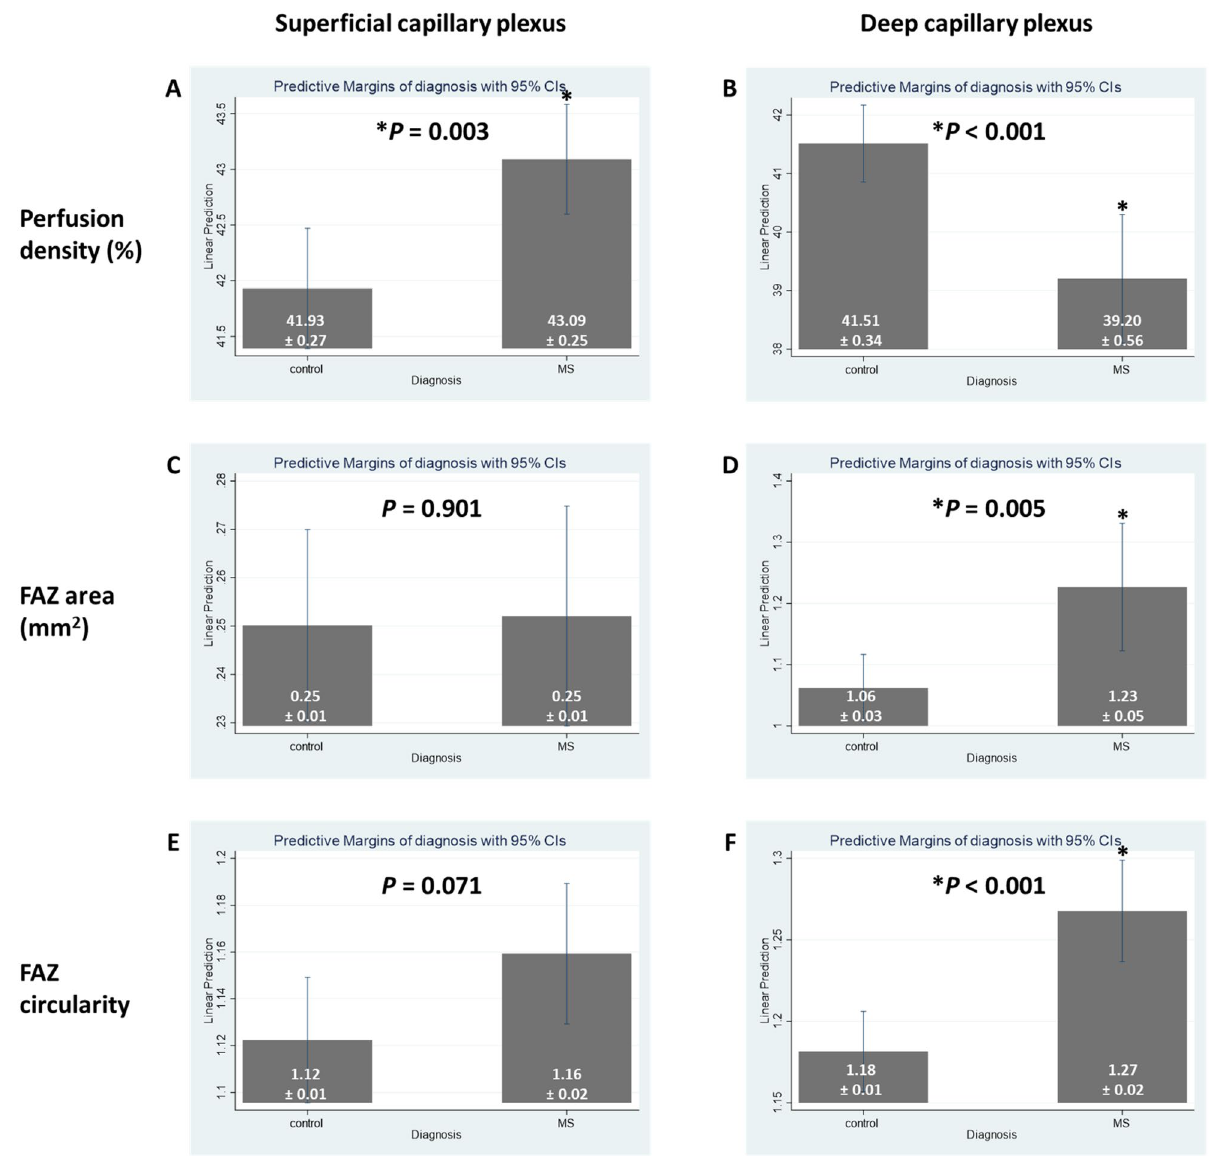
Figure 2. Distribution of ( A ) superficial perfusion density, ( B ) deep perfusion density, ( C ) superficial foveal avascular zone (FAZ) area, ( D ) deep FAZ area, ( E ) superficial FAZ circularity, and ( F ) deep FAZ circularity, stratified by participants with MS and controls. Data and P values shown are after adjustment for age, gender, hypertension, signal strength of optical coherence tomography angiography (OCTA) scans, and intraocular pressure. The asterisk symbol (*) indicates a statistical significance of P < 0.05 when compared to the